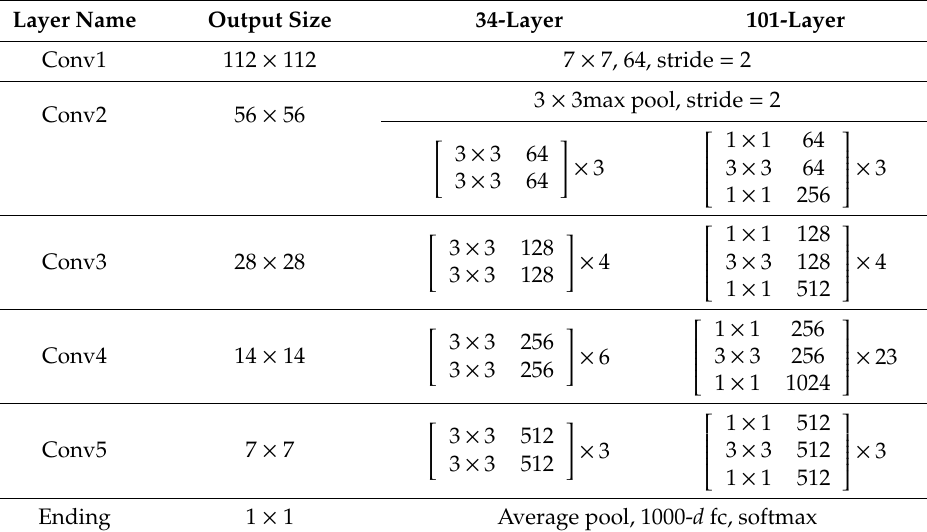
Table 1. ResNet34 and 101-layer network architecture